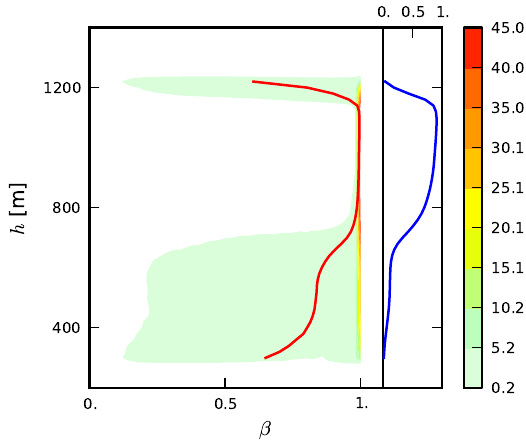
Fig. 10. CFAD of the fraction of gridbox volume occupied by the cloudy air β ; only cloudy points are included. Red line shows the average profile. The cloud fraction profile is shown on the right- hand side of the panel with the blue